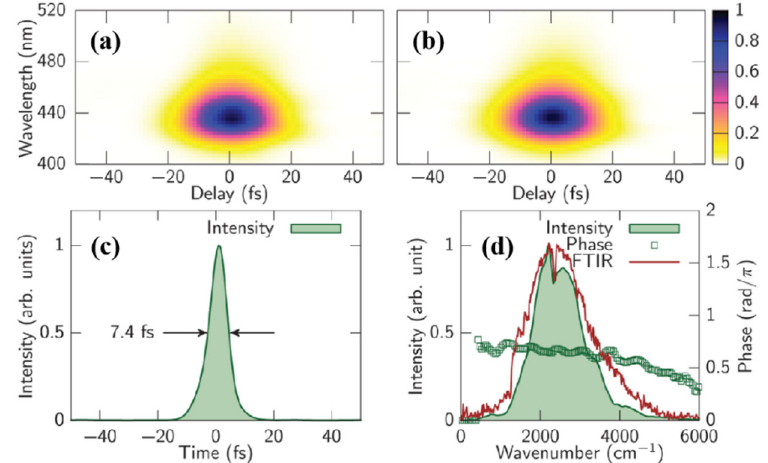
Figure 23. ( a ) Experimental and ( b ) retrieved XFROG traces. The retrieved pulse in ( c ) time and ( d ) frequency domain. The spectrum measured with Fourier transform spectrometer (brown solid curve) is also shown. Reprinted with permission from [70].